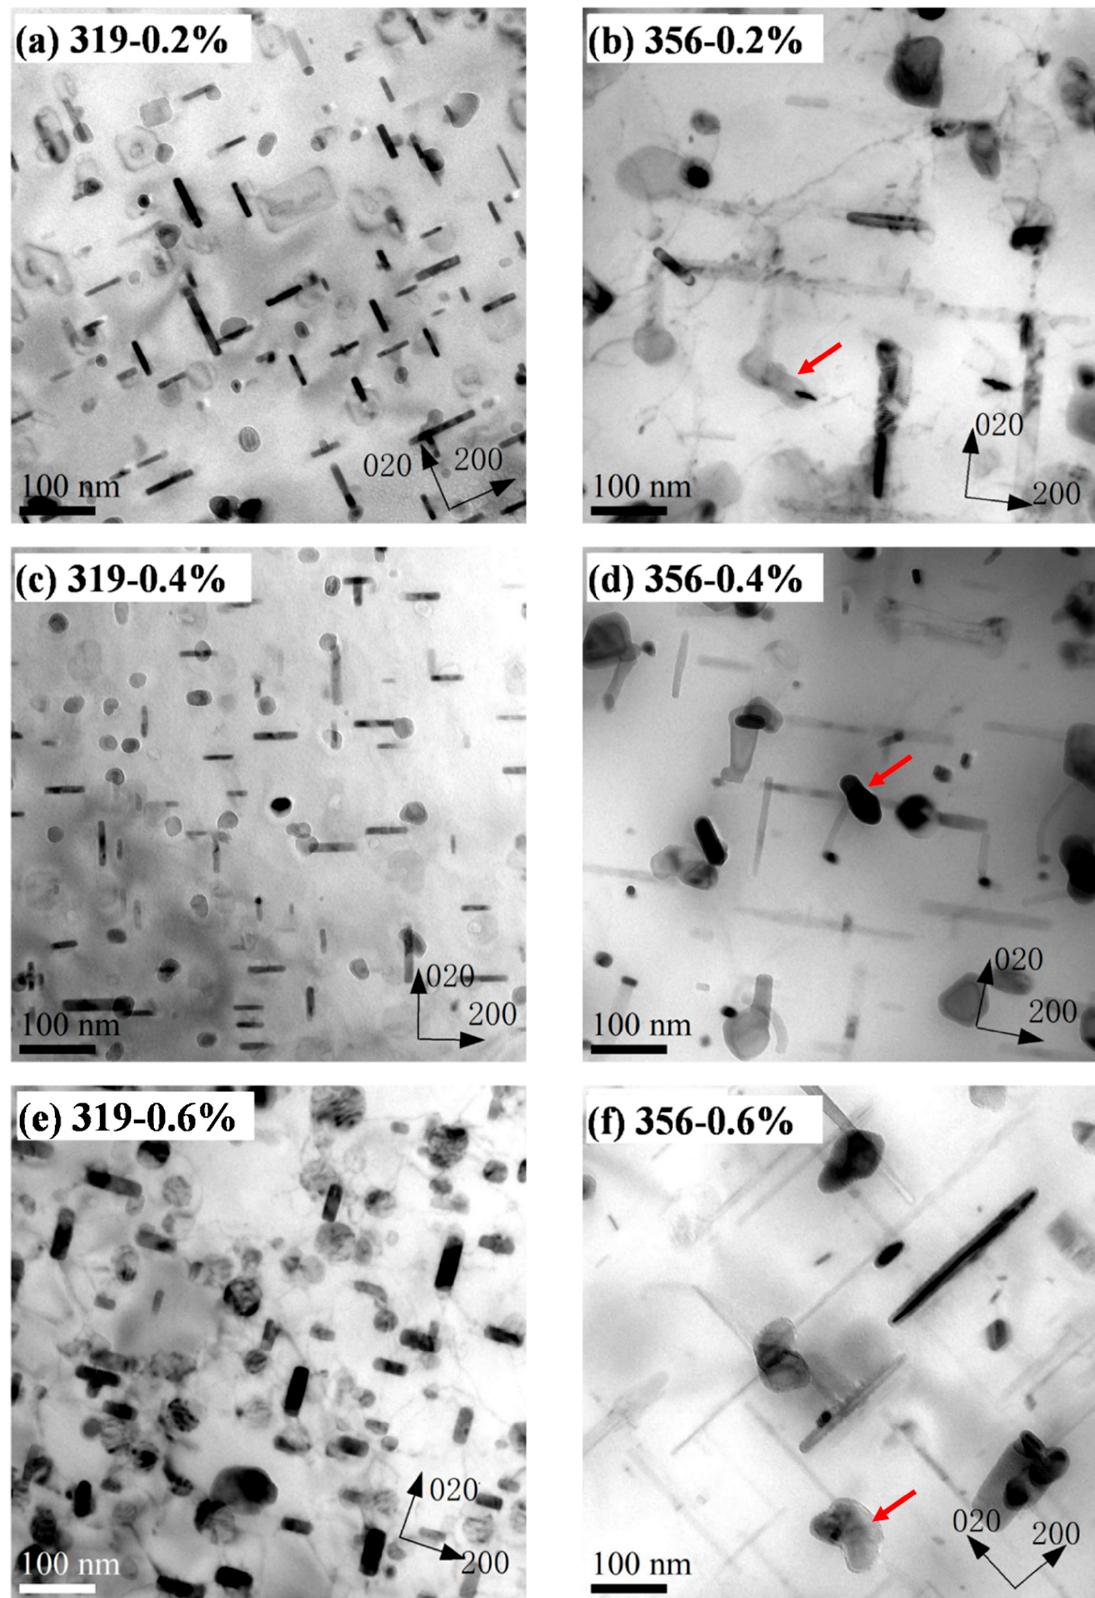
Figure 9. Bright-field TEM images showing precipitate coarsening after TMF at various strain amplitudes: ( a , c , e ) 319 alloy and ( b , d , f ) 356